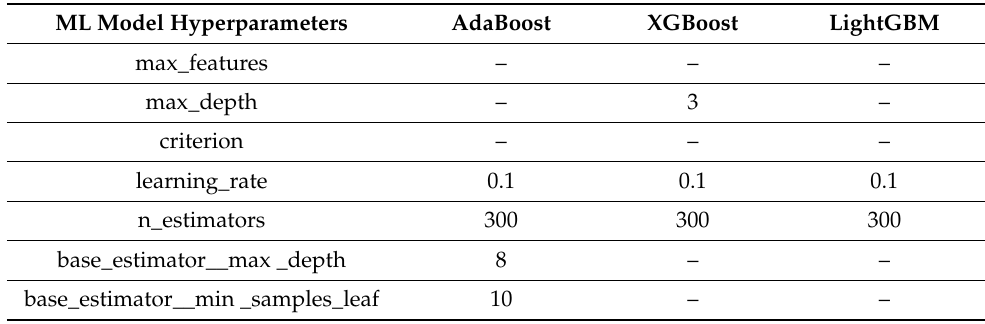
Table 1. Hyperparameters for training machine learning